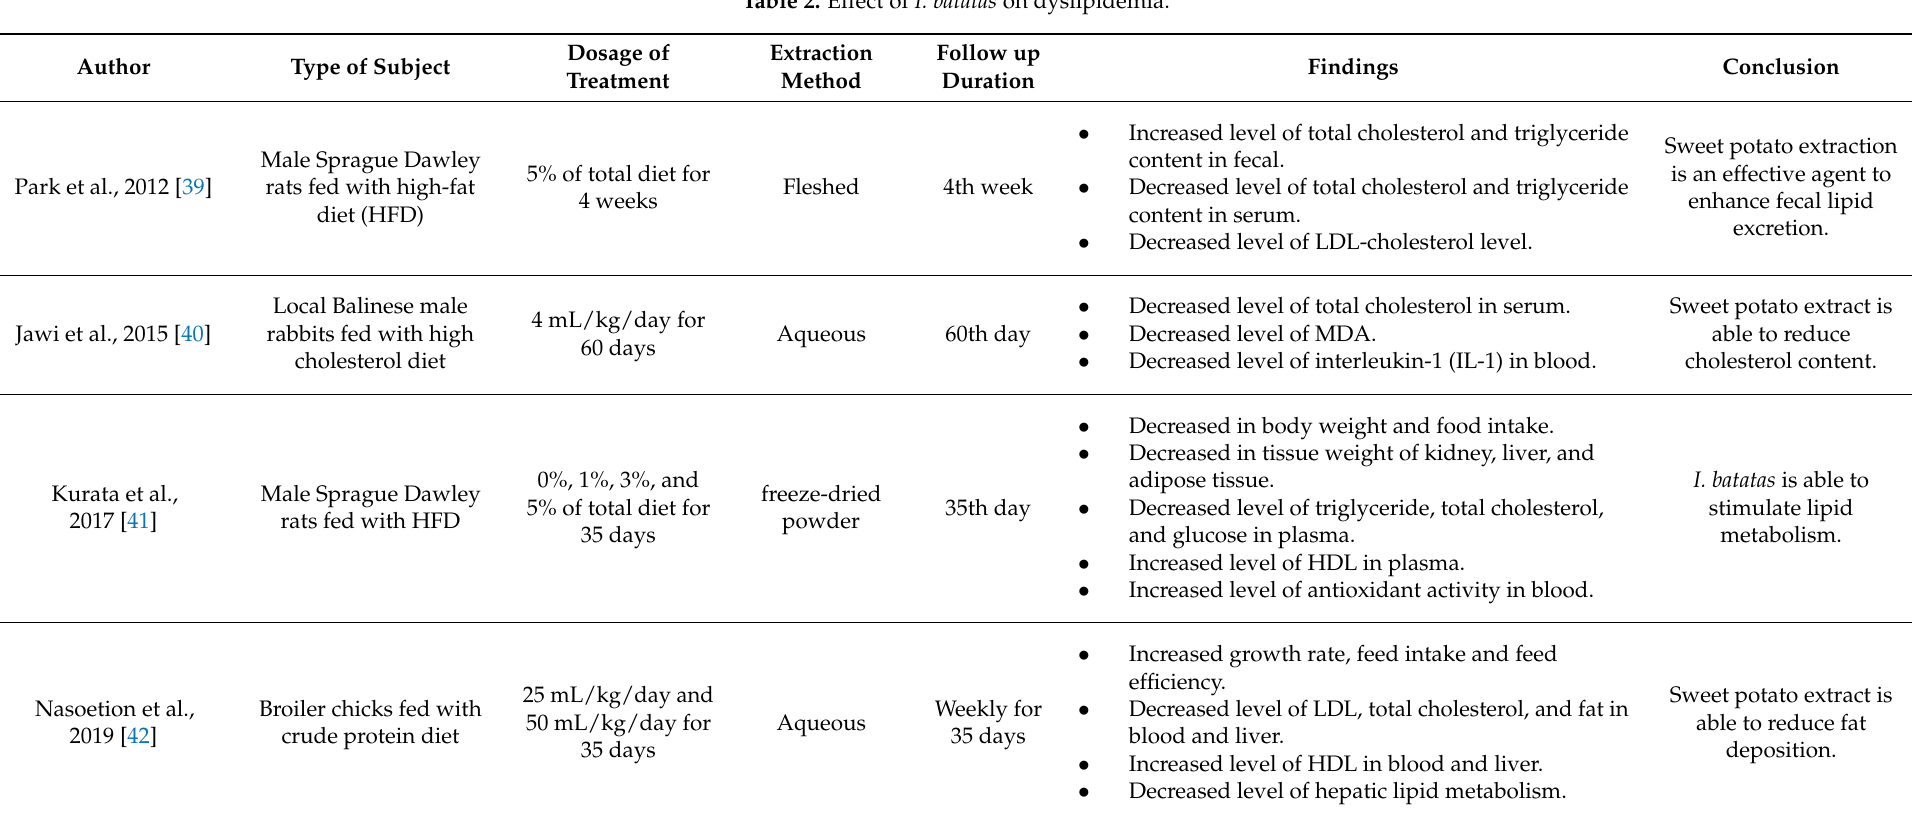
Table 2. Effect of I. batatas on